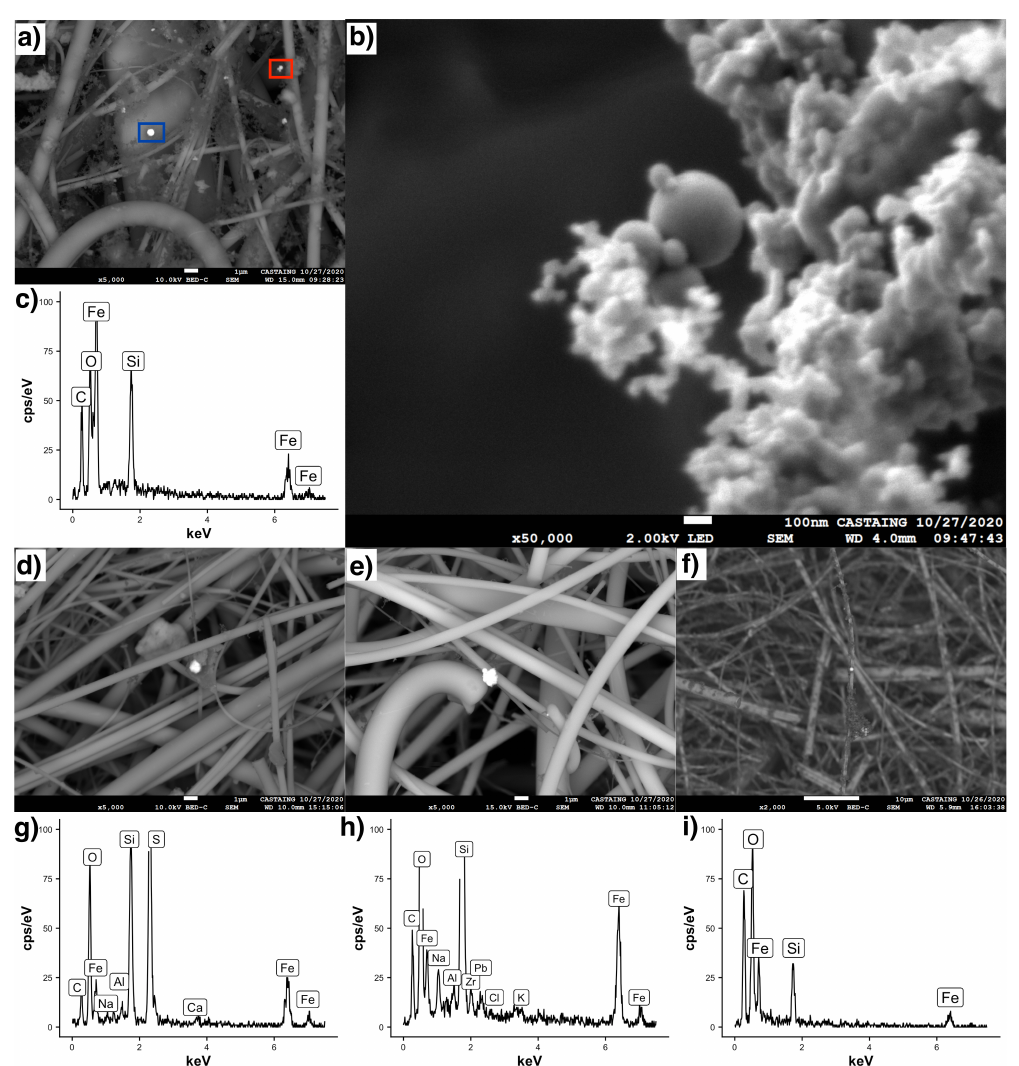
Figure 7. SEM images for the four sites: ( a ) Abidjan traffic (AT) site showing five iron oxide agglomerations and individual spherules, with sizes ranging from 50 to 500 nm. ( b ) A detail from (a) of one of the agglomerations (marked in red in figure a), displaying six spherules with sizes ranging from 50 to 300 nm. ( c ) EDS spectrum of the central spherule marked in blue in figure (a), showing a composition of Fe, O, Si and C. ( d ) Cotonou traffic site (CT), showing a particle agglomeration with a central particle composed of Fe and S with low traces of Ca, Al, Na, O. The aggregate surrounding this particle has a composition of C, Ca and Al, and a maximum dimension of 3.22 µ m. ( e ) Abidjan landfill site (AL) with a bright irregular shaped particle at the center, composed of Fe and O, and traces of Pb, Zr, Cl, K, Al, Na with dimension of 1.33 µ m. ( f ) Abidjan domestic fire site (AF), with a central spherule of 0.75 µ m in diameter, composed of Fe and O. ( g ) EDS spectrum for the central particle (marked in blue) from the CT site. ( h ) EDS spectrum from the central particle (marked in blue) from the AL site. ( i ) EDS spectrum from the spherule (marked in blue) from the AF site. All spectra have the presence of Si, related to the matrix of the filter.